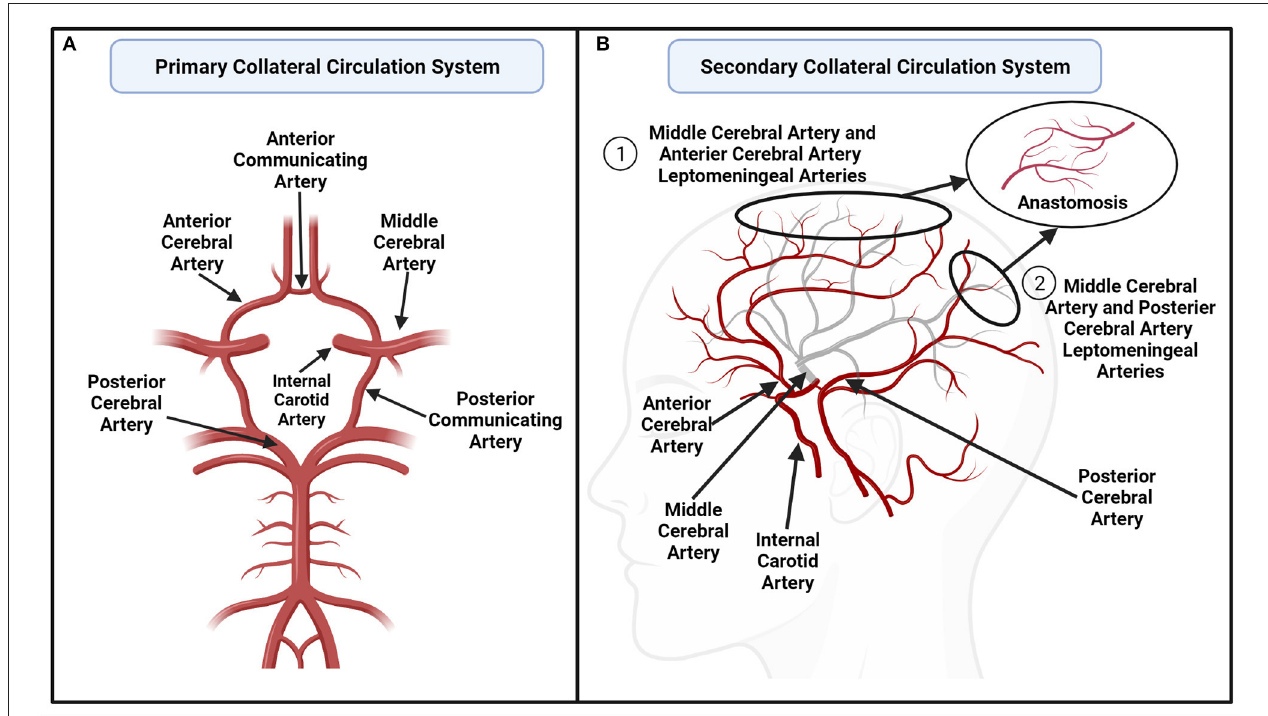
FIGURE 1 | (A) An illustration of the primary collateral circulation system, including the individual arteries of the Circle of Willis. The left and right anterior cerebral arteries (ACA) are connected by the anterior communicating artery, while the middle cerebral arteries (MCA) and posterior cerebral arteries (PCA) are connected by the posterior communicating arteries ( 25). (B) A sagittal, transparent view of selected right cerebral arteries to illustrate an example of the secondary collateral circulation system, where the MCA (gray arteries) forms leptomeningeal arterial anastomoses with the (1) ACA and (2) PCA. Created with